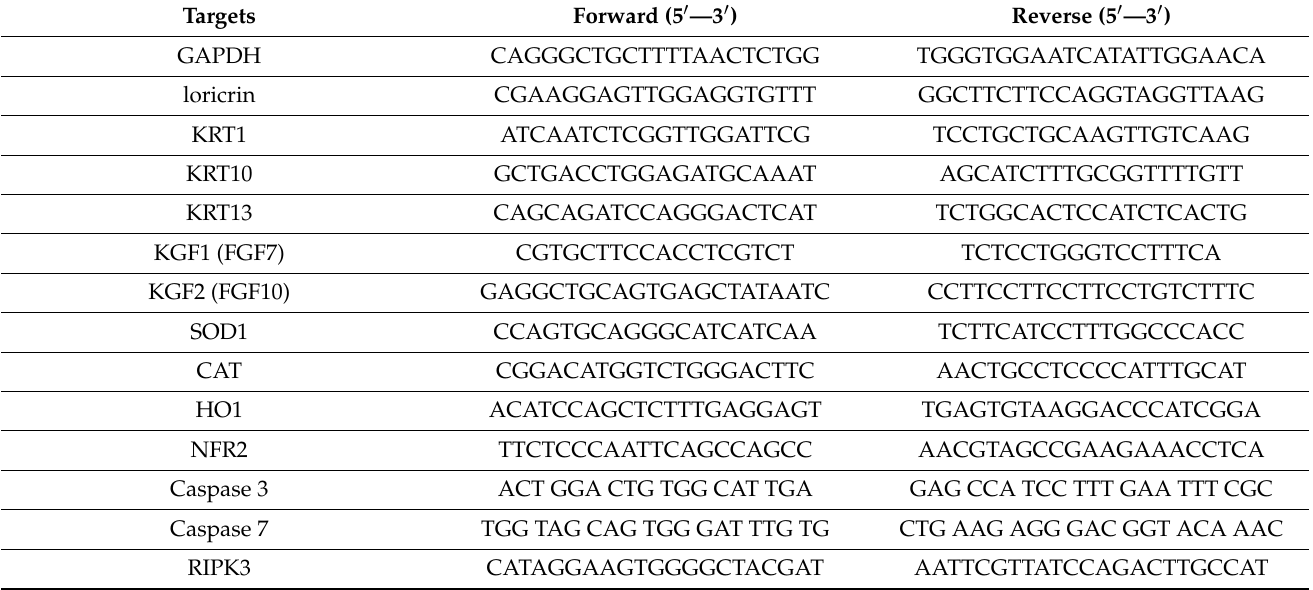
Table 1. Primer sequences for real-time